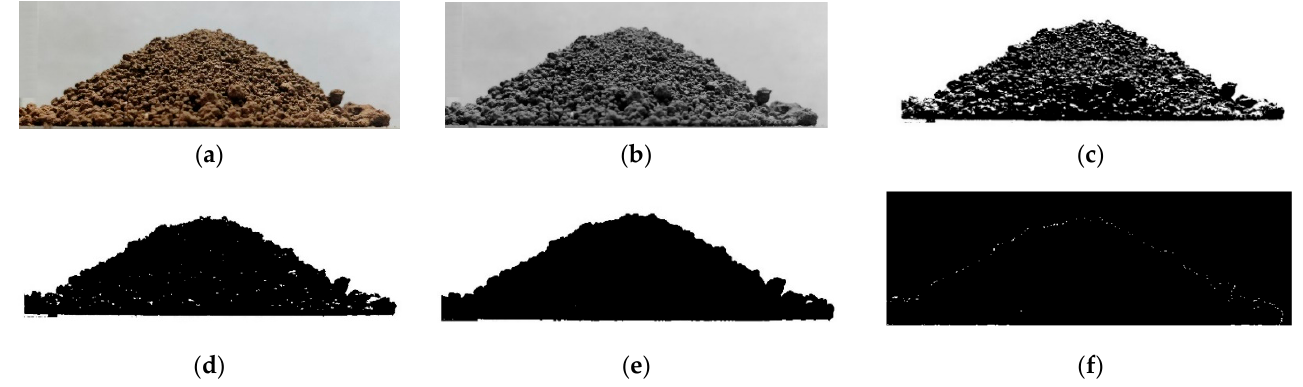
Figure 6. Edge contour extraction process for the soil repose angle: ( a ) original image, ( b ) grayscale image, ( c ) binary image, ( d ) before morphological treatment, ( e ) after morphological treatment and ( f ) contour image.